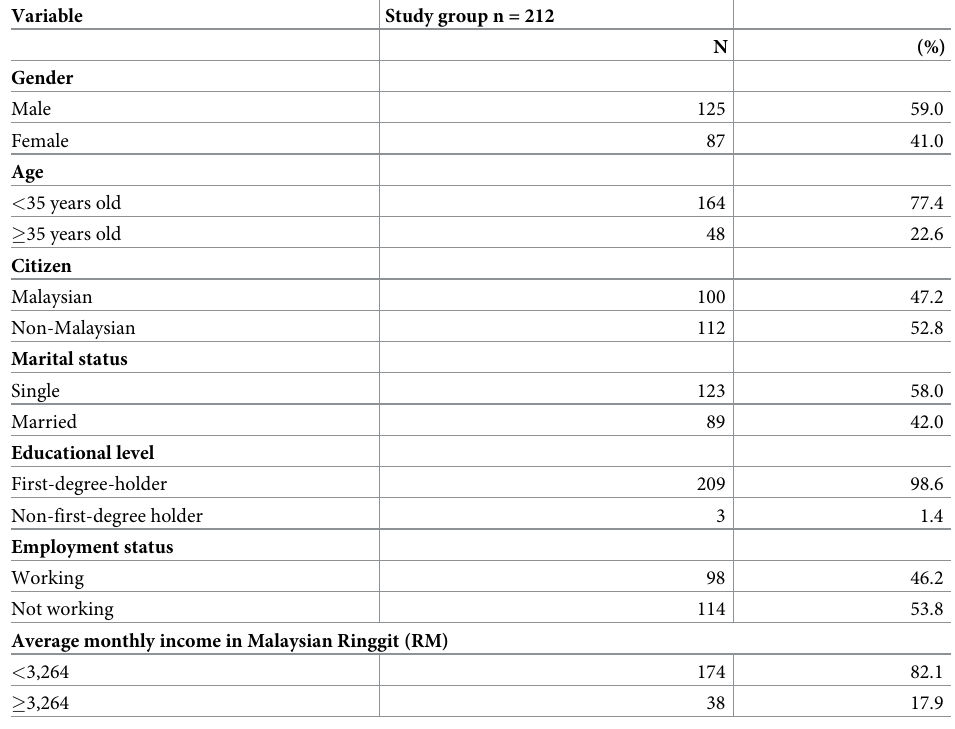
Table 1. Distribution of the respondents based on demographic (gender, age, citizen) and socioeconomic (marital status, educational level, employment status, average monthly income) characteristics (N =